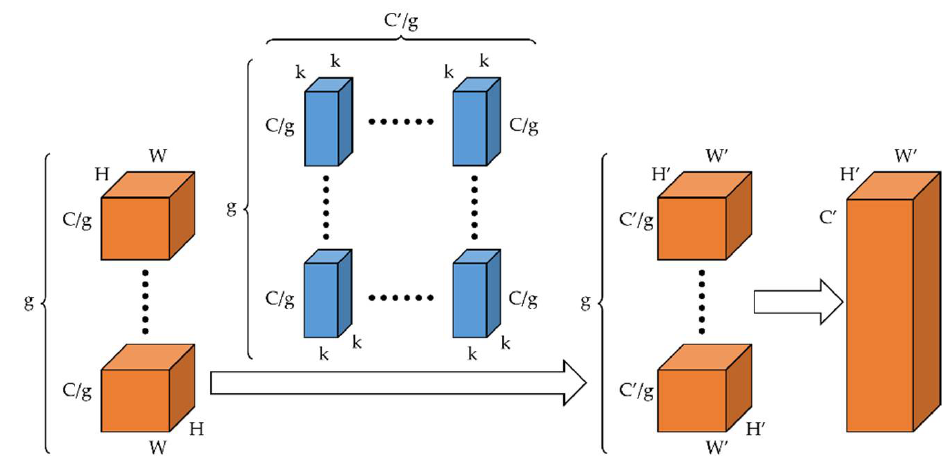
Figure 3. The residual blocks mentioned in this paper: ( a ) classic residual block; ( b ) inverted residual block; ( c ) sandglass block; and ( d ) LightSandGlass, proposed in this study.